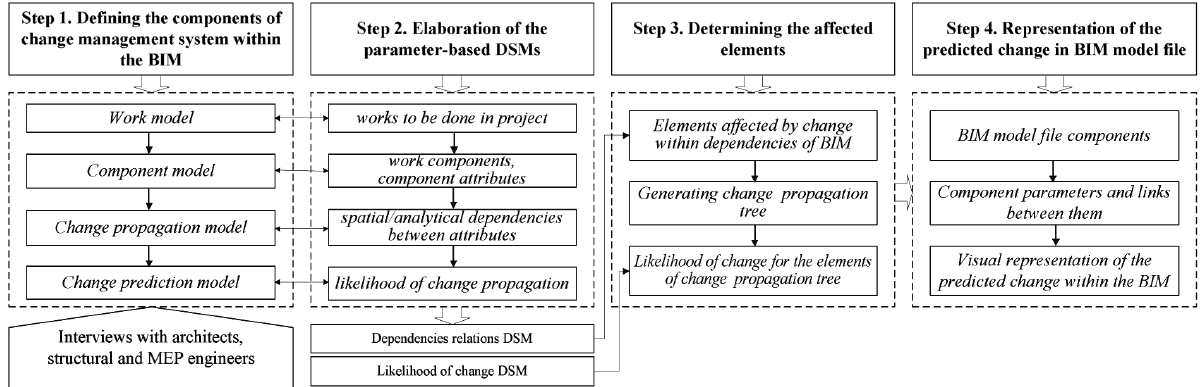
Fig. 4. Steps of proposed methodology for